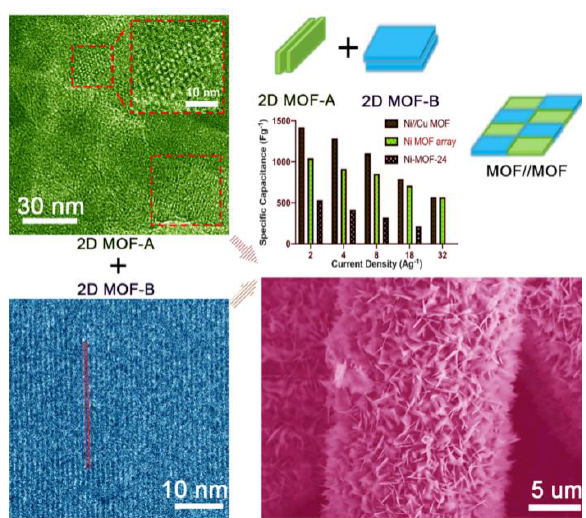
Figure 3. MOF // MOF strategy to prepare 2D Ni-MOF-24 // Cu 3 (HITP) 2 (Ni // Cu MOF) array. Figure 3. MOF//MOF strategy to prepare 2D Ni-MOF-24//Cu 3 (HITP) 2 (Ni//Cu MOF) array. Reproduced Reproduced with permission from Reference [61]. Elsevier, with permission from Reference [61]. Elsevier, 2020.